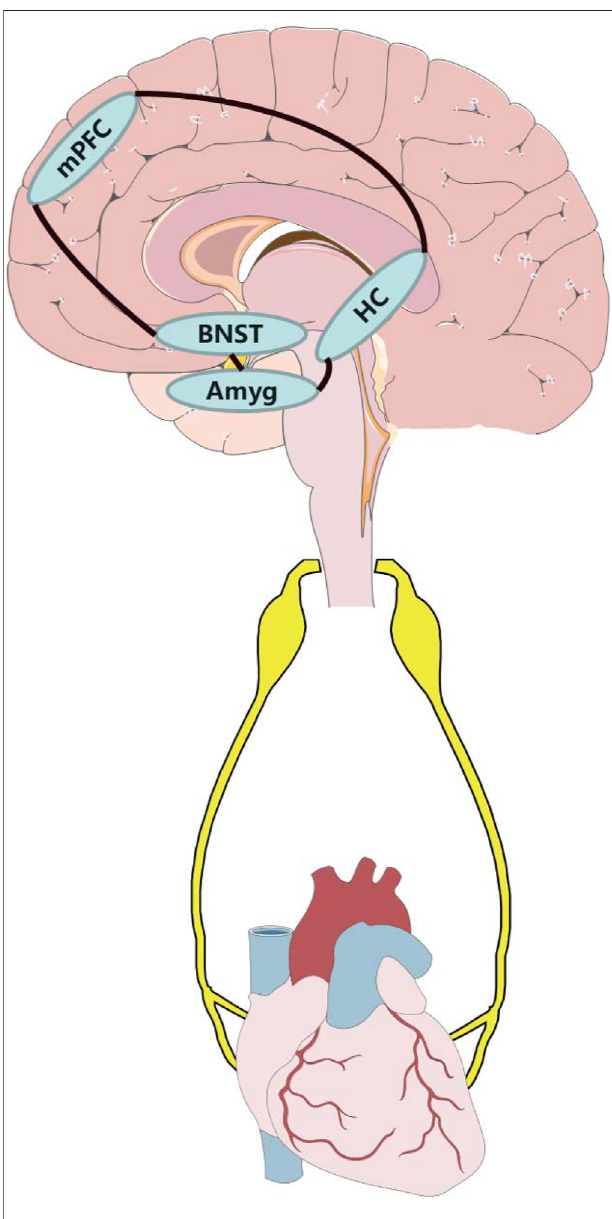
FIGURE 1 | Potential anxiety-related neural circuit in fl uence cardiovascular system through autonomic nervous system. Amyg, amygdala; BNST, bed nucleus of the stria terminalis; HC, hippocampus; mPFC, medial prefrontal